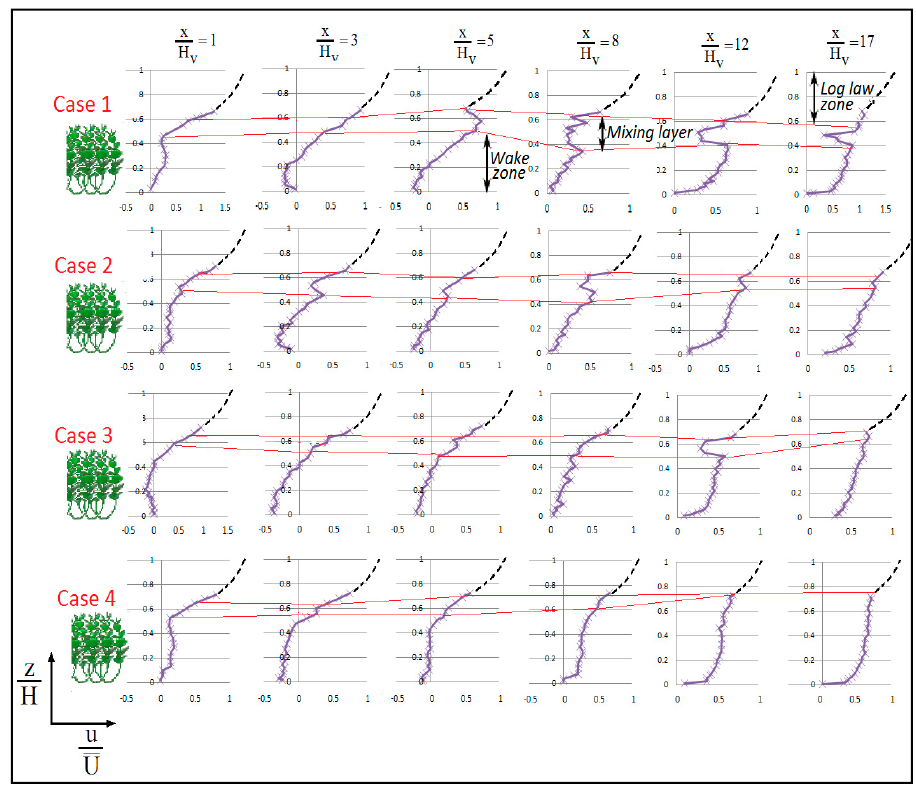
Figure 2. Streamwise velocity profiles along the centerline of the flume; x/Hv is the normalized distance from the downstream edge of the vegetation patch, and H is the depth of flow. The boundaries between zones affected by the wake and over the canopy flow are shown as red lines. The velocity of the Log–Law zone is shown as dashed and is not to